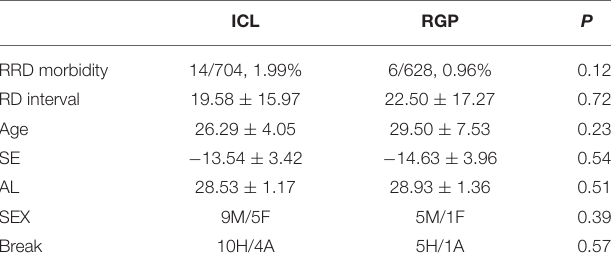
TABLE 2 | Characteristics of RRD patients at the end of